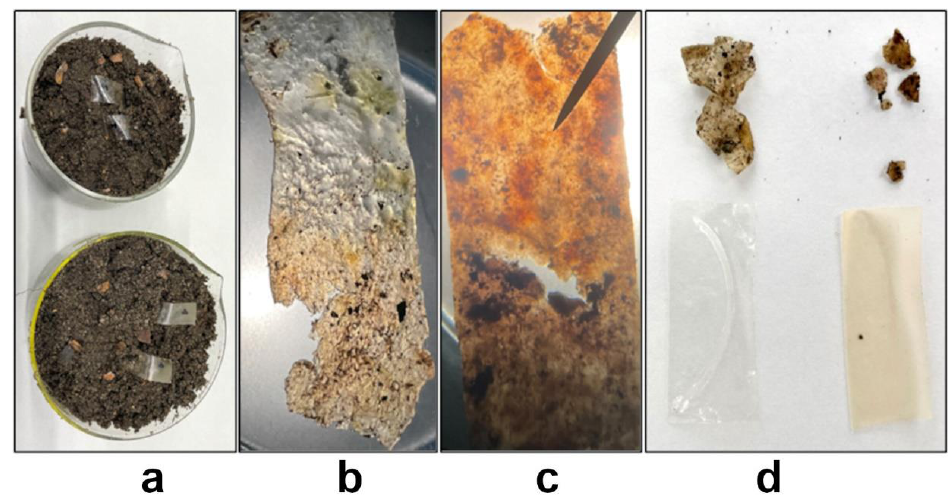
Figure 9. Biodegradability test of the film in soil (( a )—setting up the experiment, ( b )—the control film after 30 days, ( c )—the Cur-2 film after 30 days, ( d )—on the left, the control film after 60 days, on the right, the Cur-2 film after 60 days).